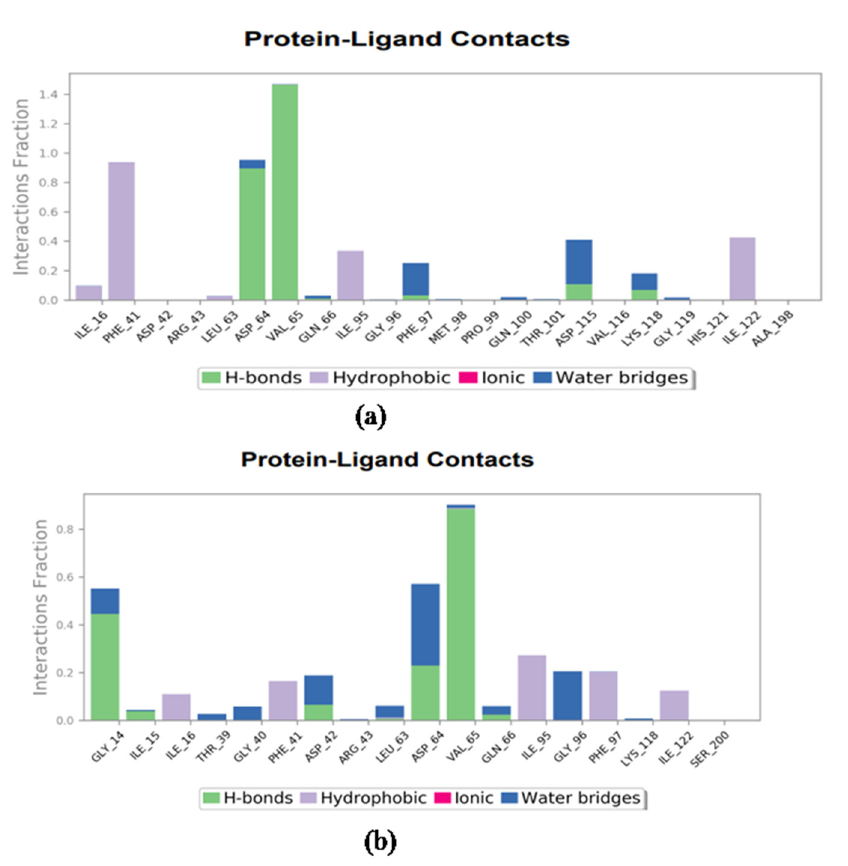
Figure 3. Protein–ligand interaction plots for ( a ) gravacridonediol and ( b )